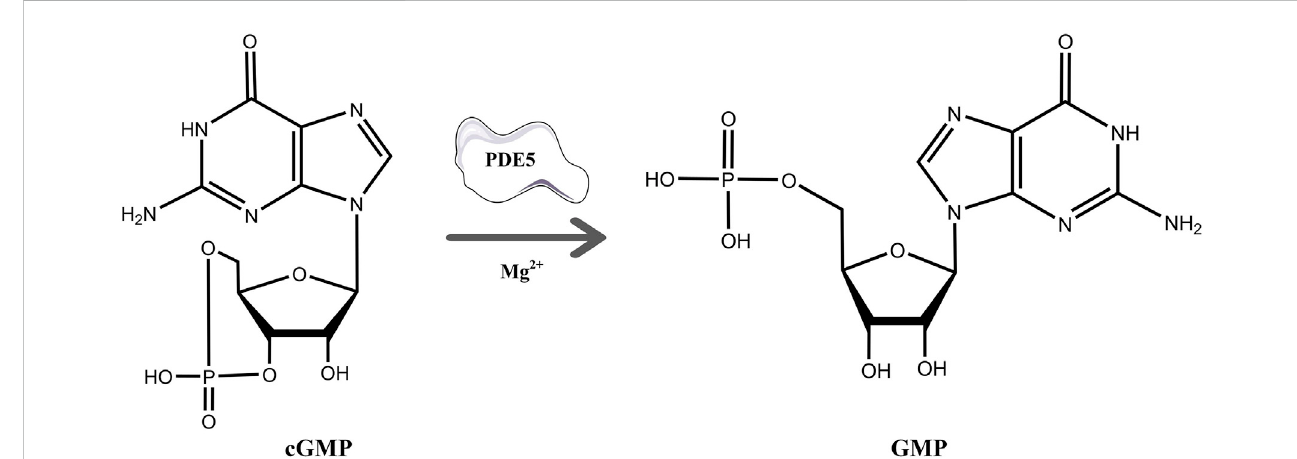
The process of hydrolysis of cGMP to GMP by PDE5A and differences in the chemical structures of cGMP and